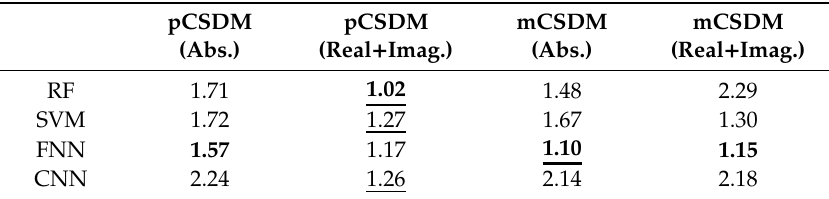
Table 3. Ratio between the percent errors in the TEST2 data and the TEST1 data (test set). The bold font indicates the minimum ratio among four machine learning algorithms for each dataset. The underscore shows the best result for each algorithm.